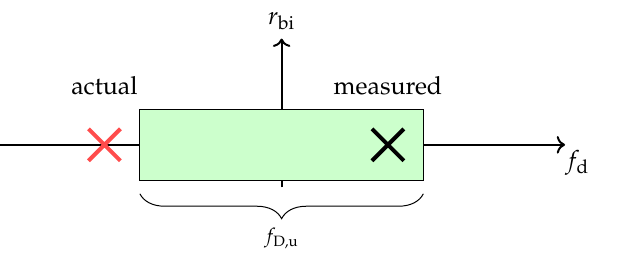
Figure 8. Illustration of the fold-over effect in unambiguous Doppler limited processing.